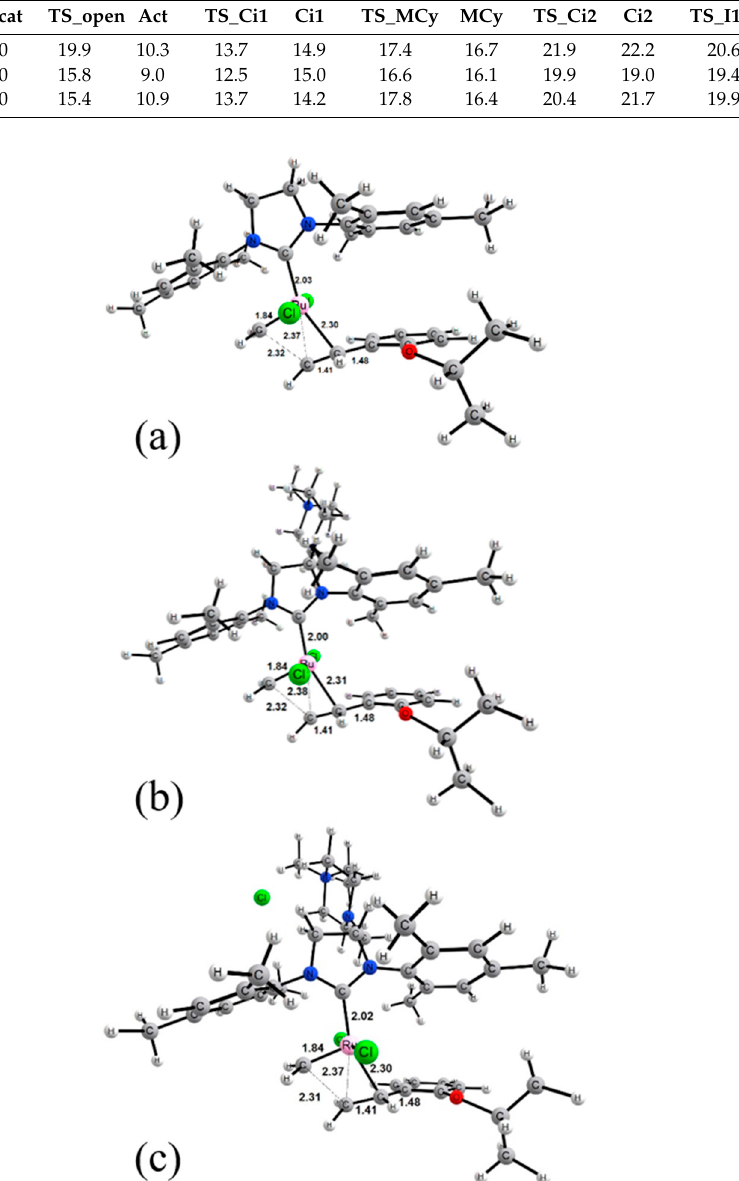
Figure 3. Transition state TS_Ci2 of the opening of the metallacycle for ( a ) HOV, ( b ) AquaMet TM + and ( c ) AquaMet TM (selected distances in Å). Table 1. Relative energies of the reaction profile of the initiation in olefin metathesis with ethylene as a substrate for the Hoveyda catalysts (HOV), with the tagged N-heterocyclic carbene (NHC) ligand, including the chloride counteranion (AquaMet TM ) or not (AquaMet TM+ ). Energy values in kcal/mol. Catalyst